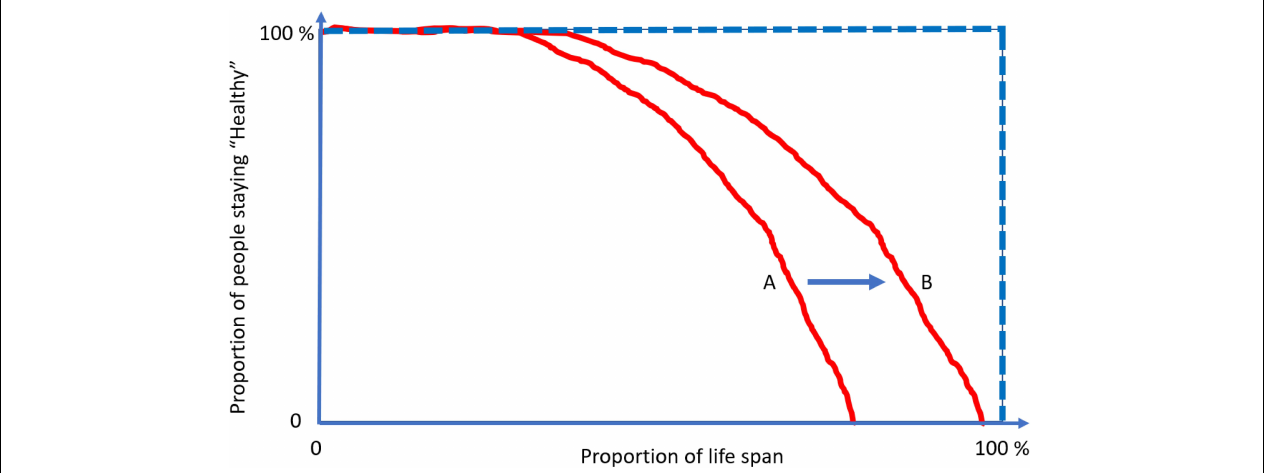
FIGURE 5 | The compression of morbidity is the “Holy Grail” of gerontologists. Interventions that increase health-span disproportionally more in life span and compress the decline in health function toward the end of life. Current demographic and epidemiological data show no evidence for “compression” of morbidity but rather suggest that the period of life characterized by illness and disability is growing at a rate faster than healthy life. Focusing on the treatment of specific diseases when they become clinically manifest rather than on the promotion of health and resiliency cannot address this situation.